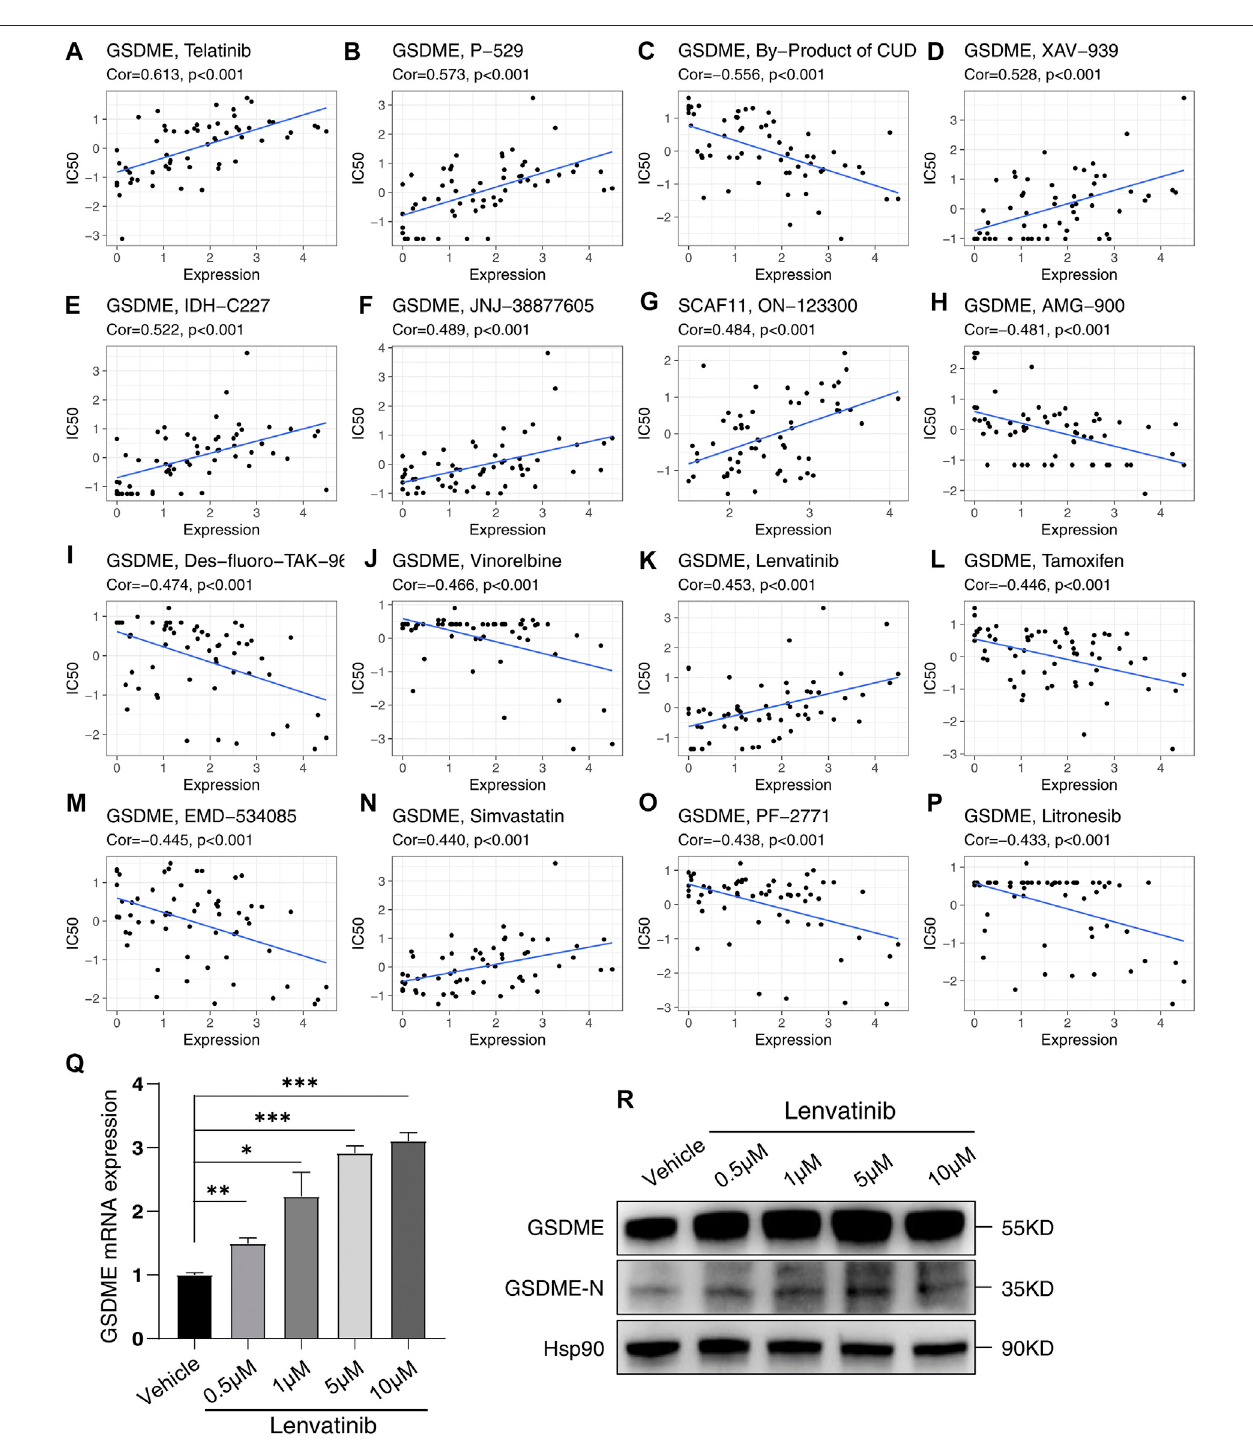
FIGURE 11 | Sensitivity correlation analysis between the independent prognostic genes and drugs based on the CellMiner Database. (A – P) Correlation analysis. (Q) Relative mRNA expression of GSDME following treatment with Lenvatinib for 48 h in Huh7. (R) Analysis of GSDME and GSDME-N terminal in Huh7 treated with Lenvatinib for 48 h by western blotting. * p < 0.05, ** p < 0.01, *** p < 0.001.